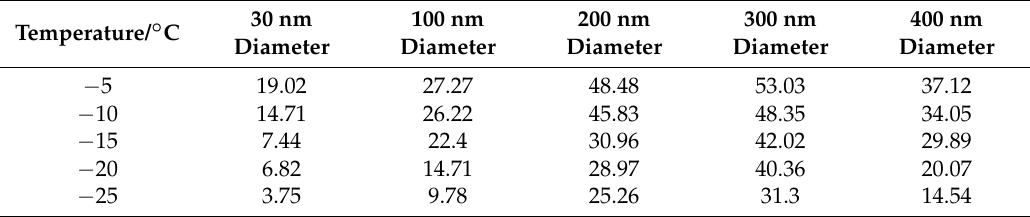
Table 3. The frost weight reduction rate of the nanoporous diameter aluminum plates compared to the polished aluminum plates at the ambition relative humidity was 60% (%). Temperature/°C